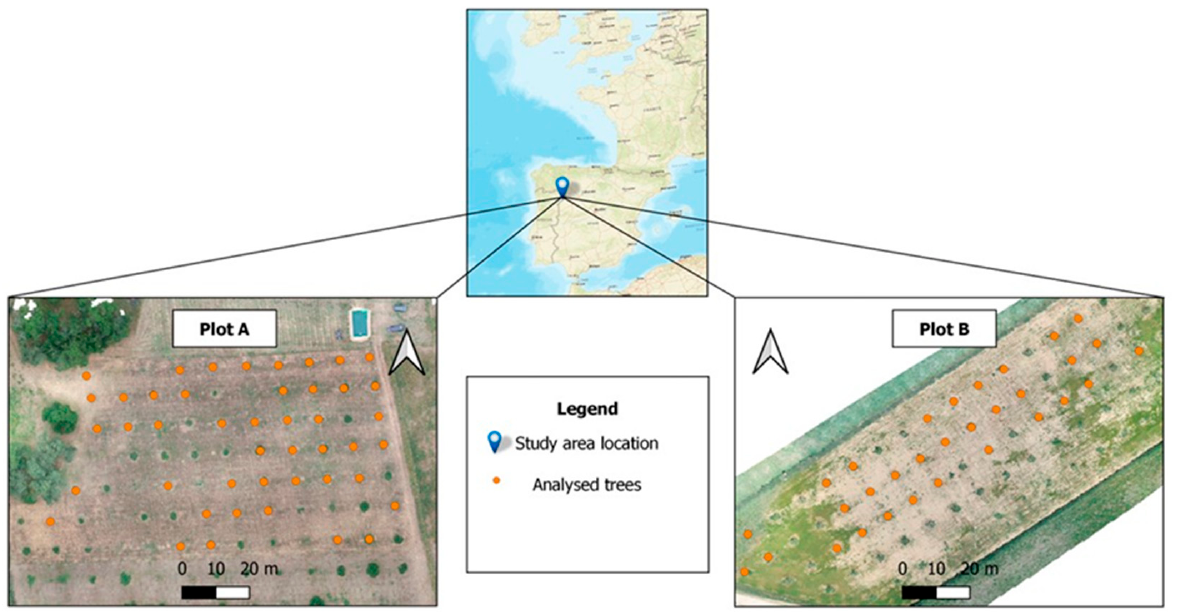
Figure 1. Study site in Robledo de las Traviesas (42° 42' 27.65'' N, 6° 26' 13.54'' W). For both plots, the analysed trees are depicted in an UAV orthoimage.